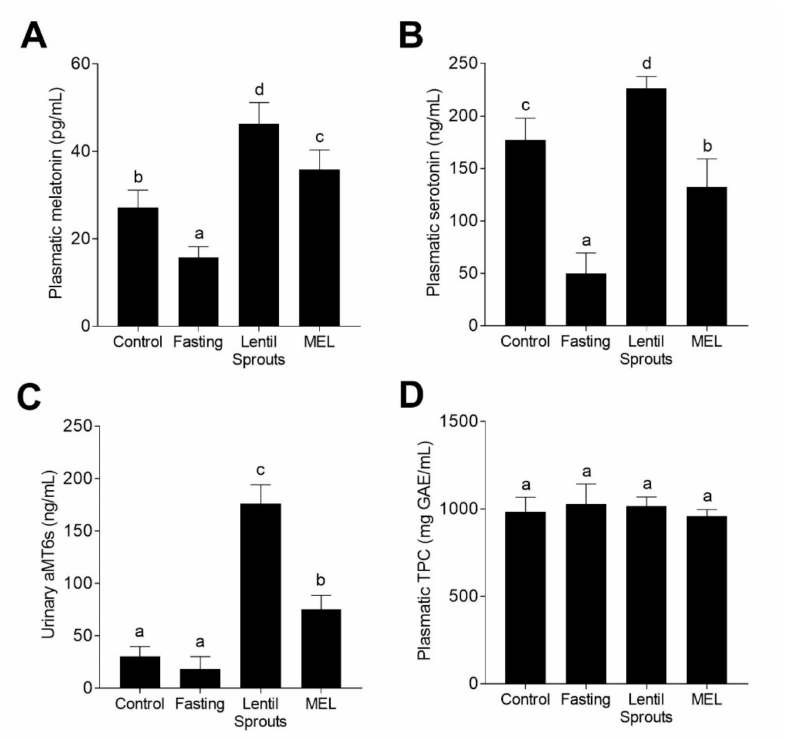
Figure 4. The concentration of melatonin ( A ), serotonin ( B ), 6-sulfatoxymelatonin (aMT6s) ( C ), and TPC ( D ) in the plasma and urine samples followed the four experimental conditions (Control, Fasting, Lentil Sprouts, and MEL). The results are expressed as mean ± SD ( n = 10). Bars with di ff erent letters significantly ( p < 0.05) di ff er according to ANOVA and Tukey’s multiple range